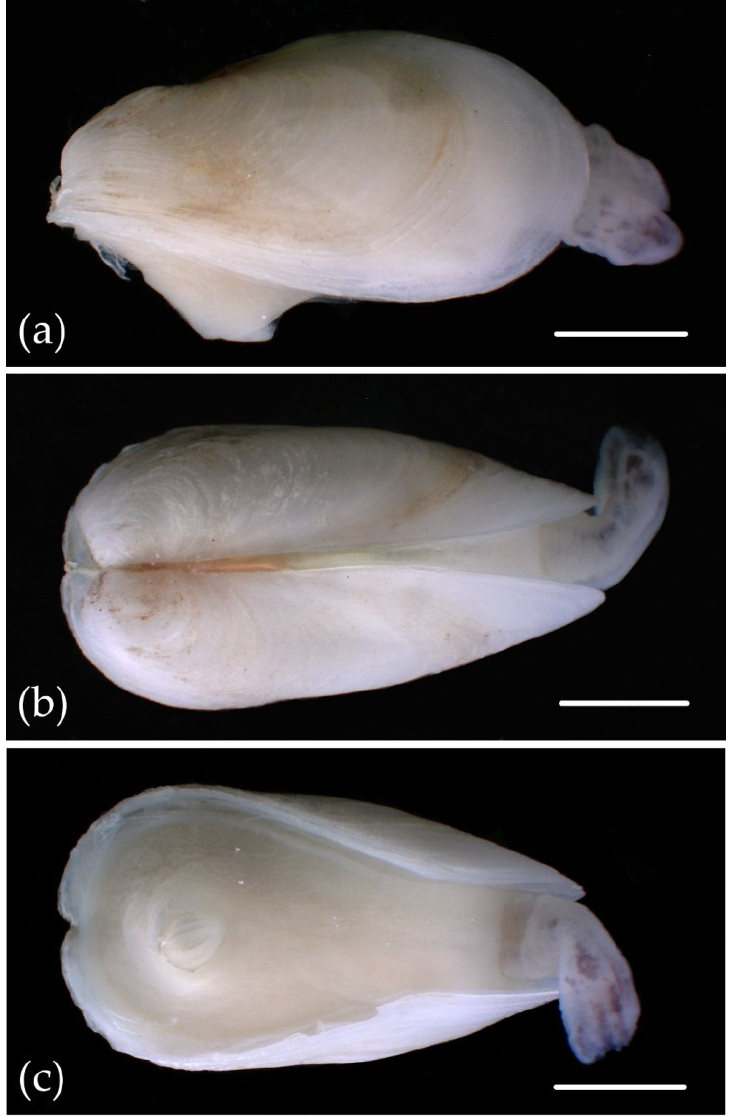
Figure 4. Rocellaria dubia extracted from the oyster Magallana gigas : ( a ) lateral view, right valve; ( b ) dorsal view; ( c ) ventral view. Scale bars—2 mm.